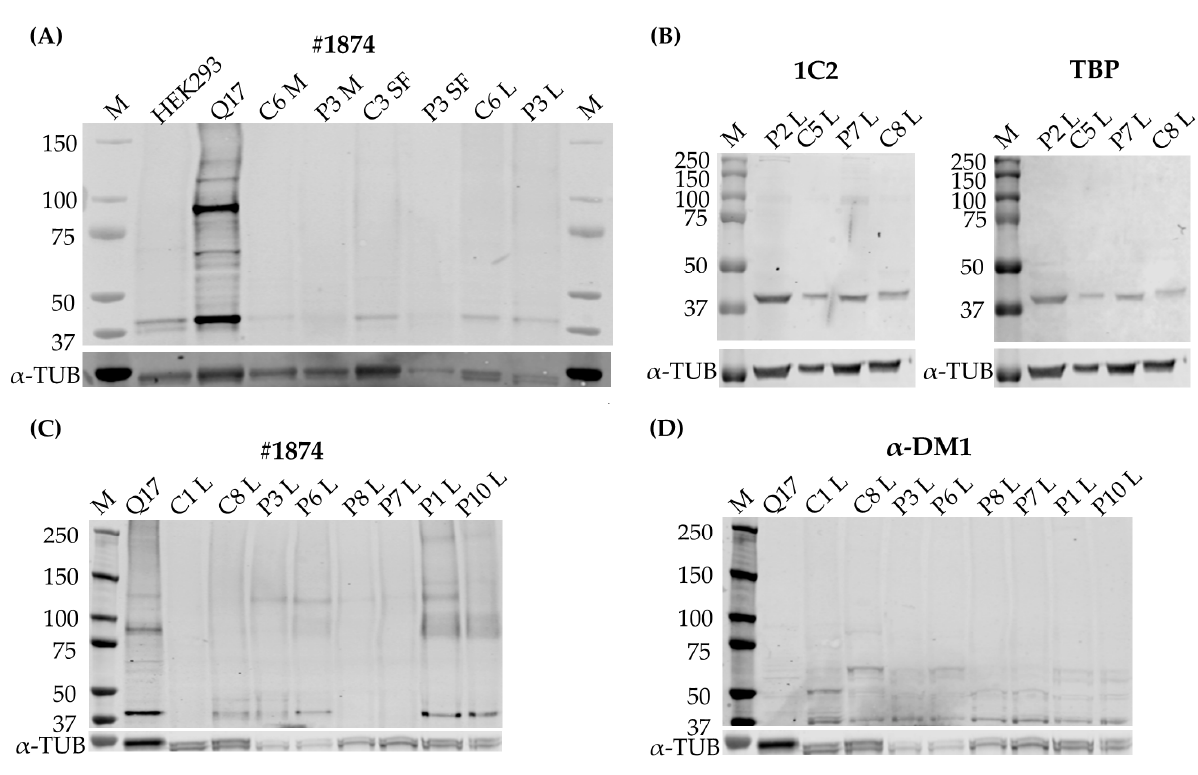
Figure 3. Quantitative analysis of repeat associated non-ATG (RAN) translated polyglutamine (polyGln) protein. ( A ) A representative immunoblot with #1874 1:1000, including all three primary cell cultures, our positive control, a huntingtin vector containing 17 polyglutamine stretches (Q17), and a negative control, consisting of untransfected HEK293 cells (C: n = 4, P: n = 4). ( B ) Immunoblot showing co-localization of the 42 kD protein found with #1874 and 1C2 with TATA-box-binding protein (TBP) in lymphoblastoids. The antibody shown here is 1C2. ( C ) Immunoblot of lymphoblastoid cell lines, two controls and six patients with #1874 showing several higher bands in certain DM1 patients. ( D ) Immunoblot with the custom antibody α -DM1, showing several non-specific bands, but none that overlap with the bands found with #1874. Abbreviations: M = marker; C = control; P = DM1 patient; HEK293 = untransfected HEK293 cells; Q17 = Q17 huntingtin vector; M = myoblasts; SF = skin fibroblasts; L = lymphoblastoids. #1874 = commercial antibody recognizing polyGln; α - DM1 = custom antibody against the predicted C-terminus of the polyGln RAN protein; α -TUB = α -tubulin as endogenous control.